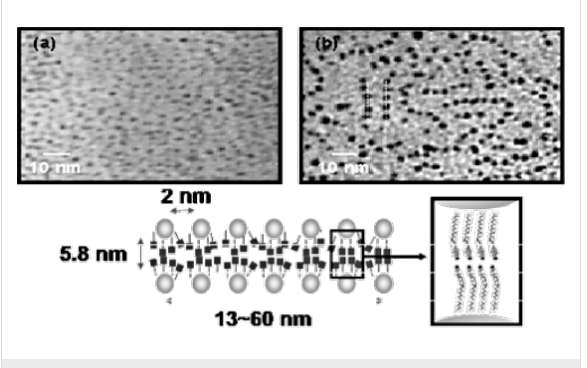
Figure 5: TEM images of Au@6 12 (a) before and (b) after thermal treatment. Below: Proposed model of the nanoparticle arrangement within the strings. Reproduced by permission of The Royal Society of Chemistry